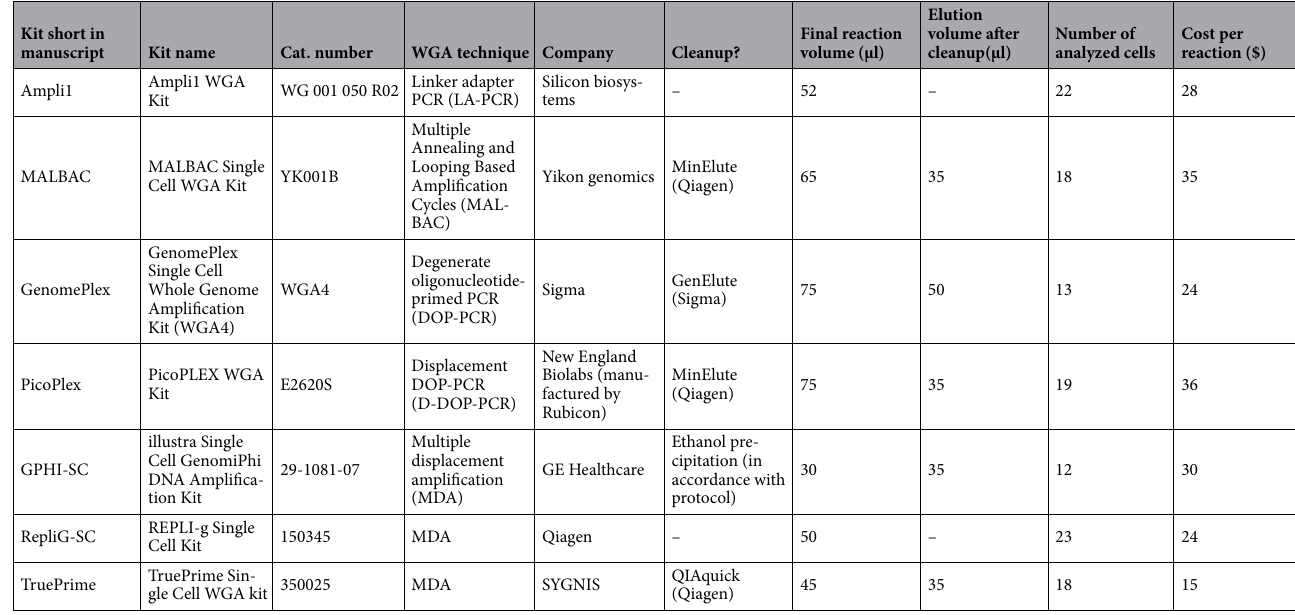
Table 1. Summary of participating scWGA